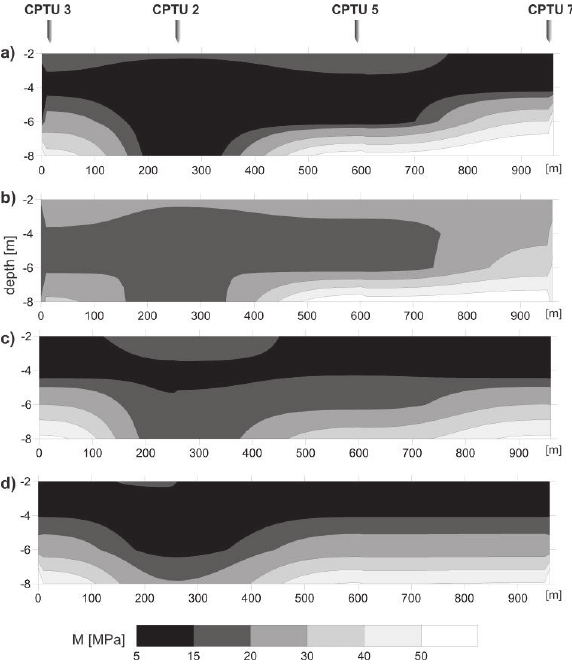
Figure 10: Models of subsoil rigidity composed on the basis of cons- Figure 10. Models of subsoil rigidity composed on the basis of constrained moduli M along a section selected in trained modulus M along a section selected in the investigated area, the investigated area, determined by IDW based on: values of moduli determined from formulas 4 and 5 (a), mean determined by IDW based on (a) values of moduli determined from values of moduli for isolated soil layers (b), the mean of the function f(z)=M for isolations in the depth range of 2 Eqs. (4) and (5), (b) mean values of moduli for isolated soil layers, - 8 m (c) and the mean of the function f(z)=M for isolations in depth ranges of 2 - 5 m and 5 - 8 m (d). (c) the mean of the function f(z) = M for isolations in the depth range